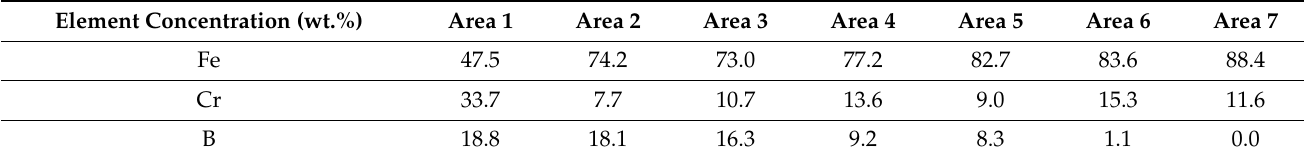
Table 2. The results of EDS X-ray microanalysis performed in areas marked in Figure 6. Element Concentration (wt.%)